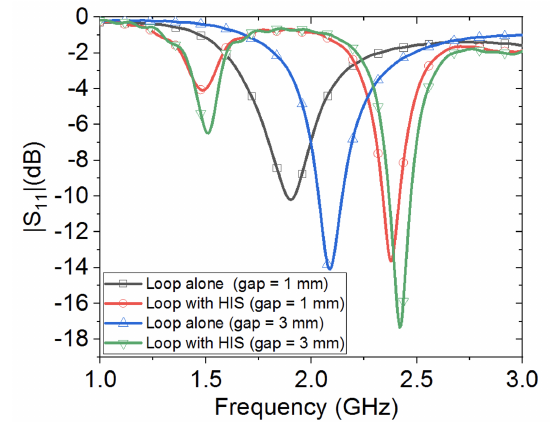
Figure 26. Computed reflection coefficient for the wearable loop antenna with and without HIS on top of modeled human arm with spacing of 1 mm and 3